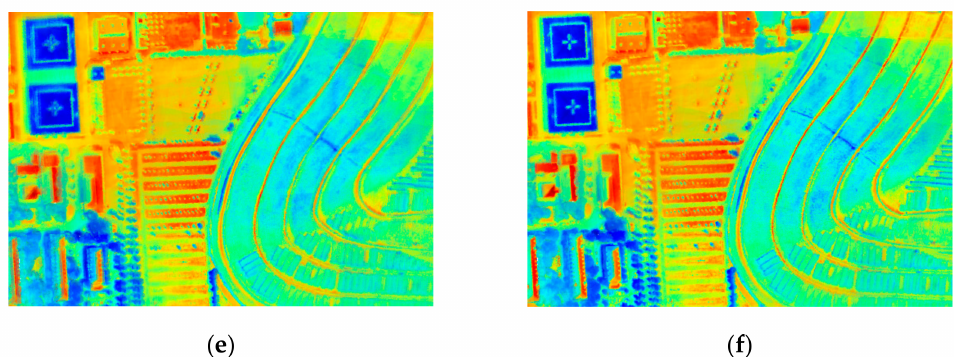
Figure 10. Comparisons of enlarged areas. Texture mapping results using strategy 2 for ( a ) building area, ( c ) river ecosystem, and ( e ) soil area; texture mapping results using strategy 3 for ( b ) building area, ( d ) river ecosystem, and ( f ) soil area. Table 4. ( a ) Geometric misalignment d for check points in building area (m). ( b ) Geometric